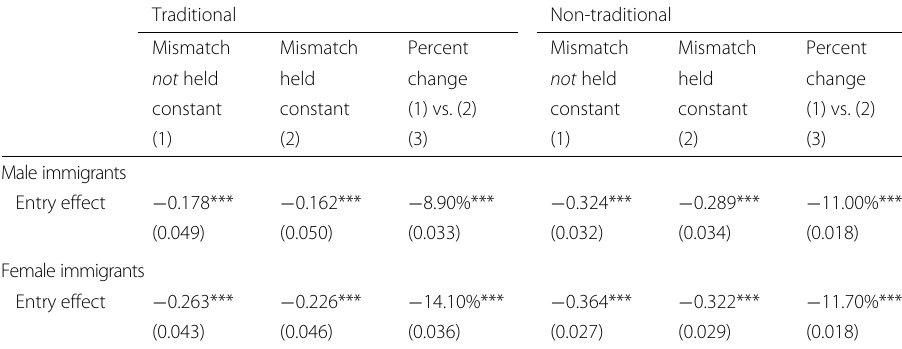
Table 8 Percent of entry effect due to mismatch: traditional vs. non-traditional immigrants